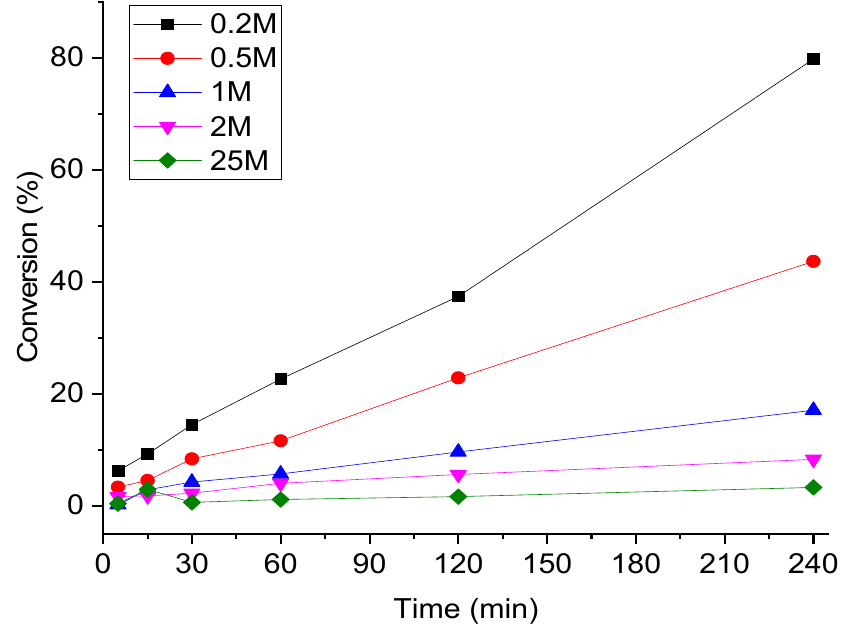
Figure 8. Effect of FA concentration on the decomposition process over 1%Ir:2%Pd/C. Reaction conditions: catalyst (substrate:metal molar ratio = 2000:1), 700 rpm, and 240 min.